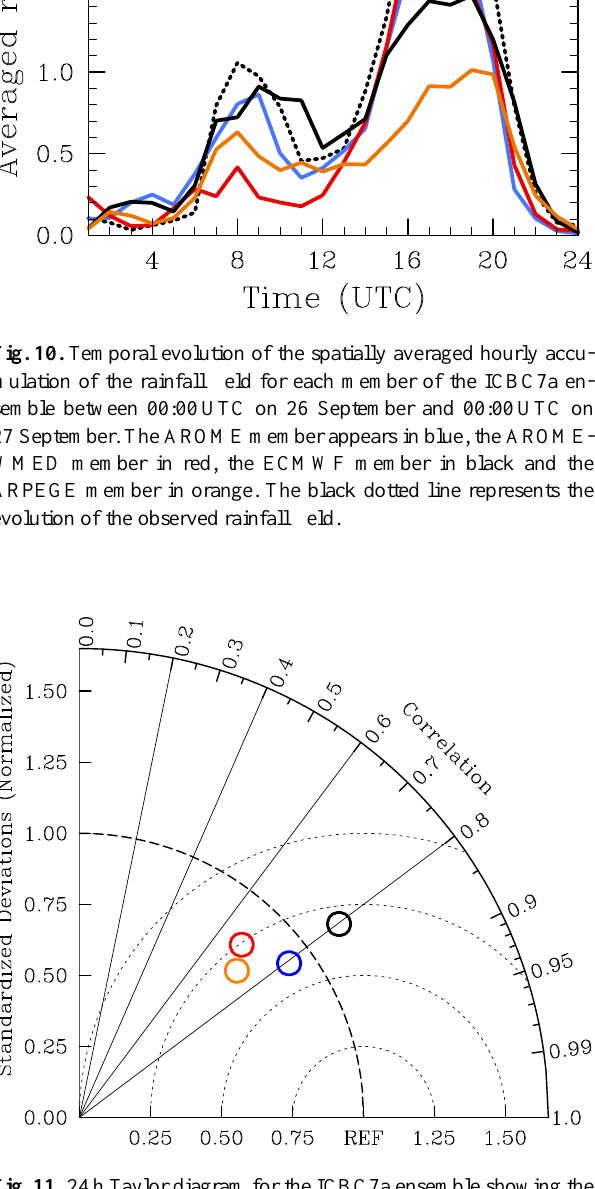
Fig. 11. 24h Taylor diagram for the ICBC7a ensemble showing the spatial correlation, standard deviation and RMSE of the simulated rainfall with the observed rainfall for the AROME (blue circle), AROME-WMED (red circle), ECMWF (black circle) and ARPEGE (orange circle) members of the